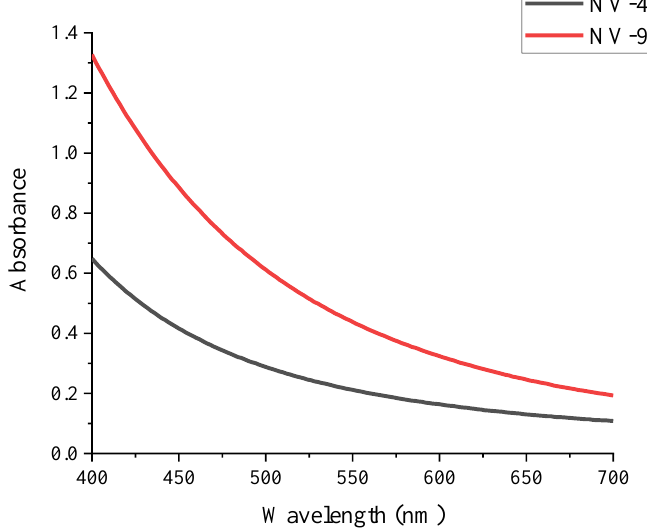
Figure 2. Visible spectra of NV NDs (water, 0.1 mg/mL).